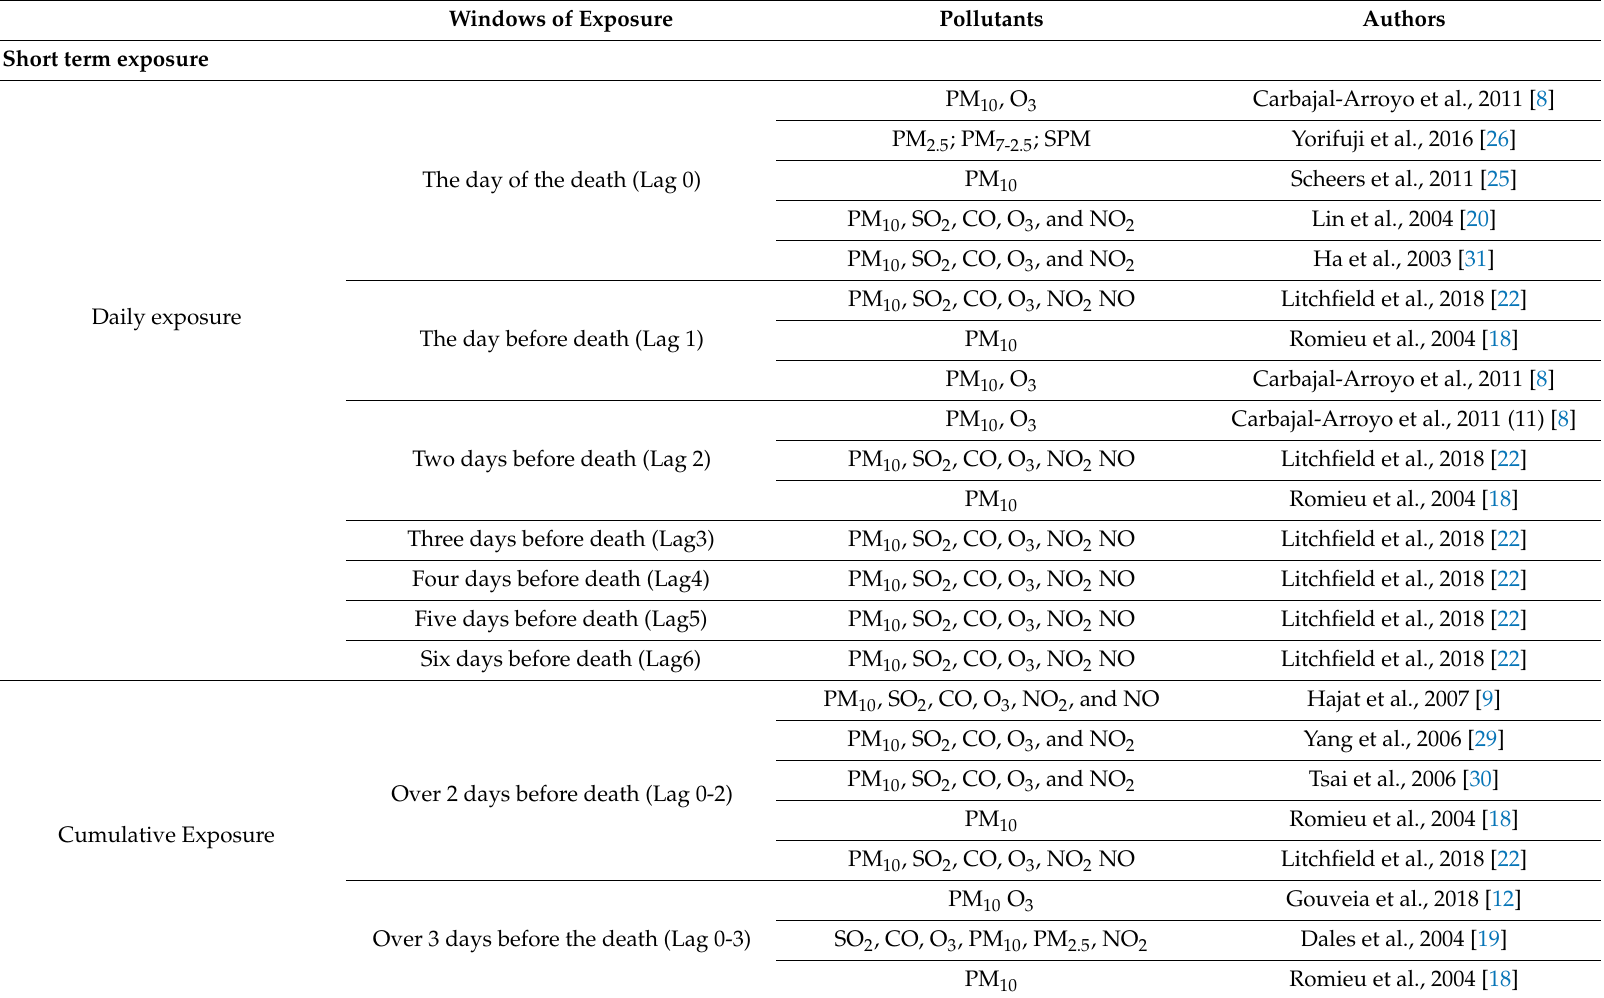
Table 3. Definition and assessment of window of